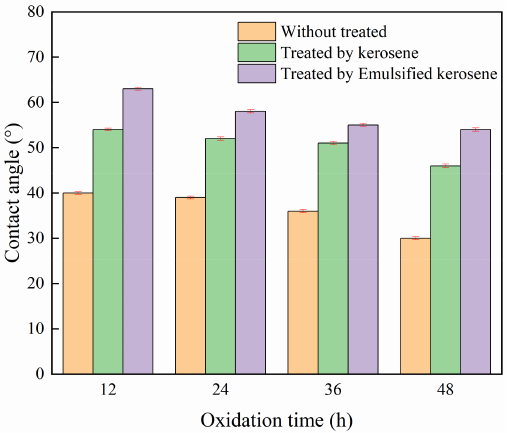
Figure 9. Contact angles of oxidized coals treated with kerosene and emulsified kerosene. For conventional conditions (only kerosene), the collector and dosage were 500 g/t kerosene. For the mixture reagent (emulsified kerosene), the equivalent kerosene dosage was also kept as 500 g/t as a control